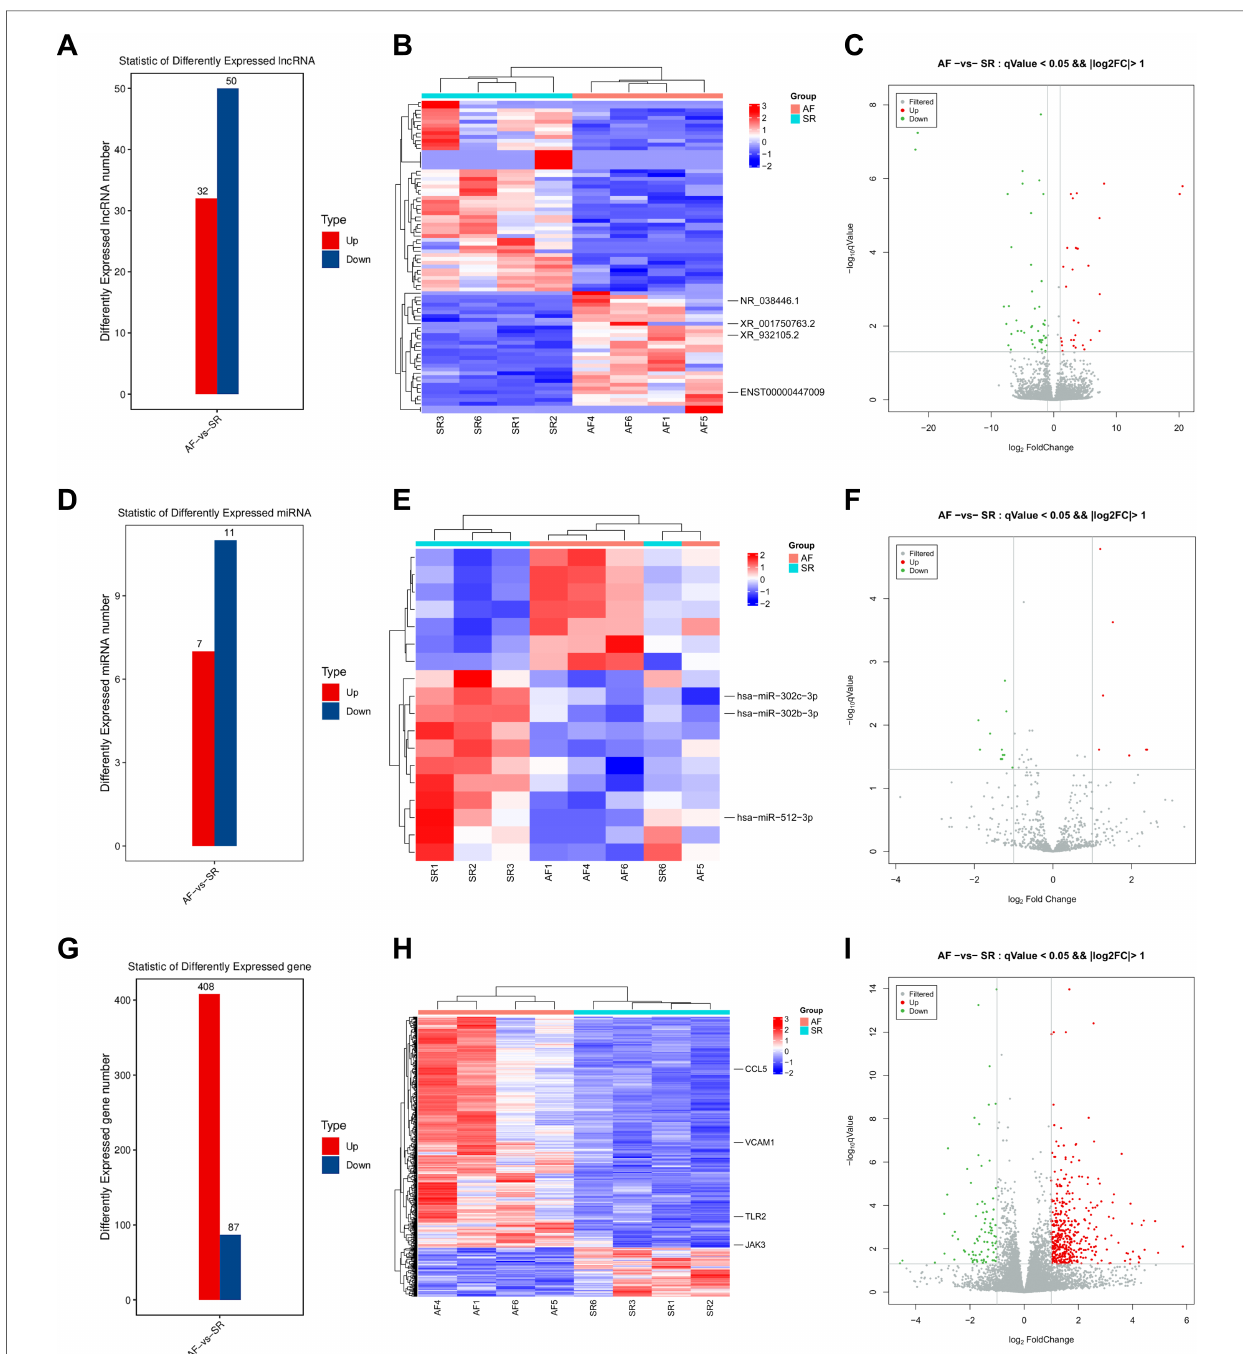
FIGURE 4 DElncRNAs, DEmiRNAs, and DEmRNAs. The DElncRNA number ( A ), heatmap ( B ), and volcano plot ( C ) comparisons between the two groups. The DEmiRNA number ( D ), heatmap ( E ), and volcano plot ( F ) comparisons between the two groups. The DEmRNA number ( G ), heatmap ( H ), and volcano plot ( I ) comparisons between the two